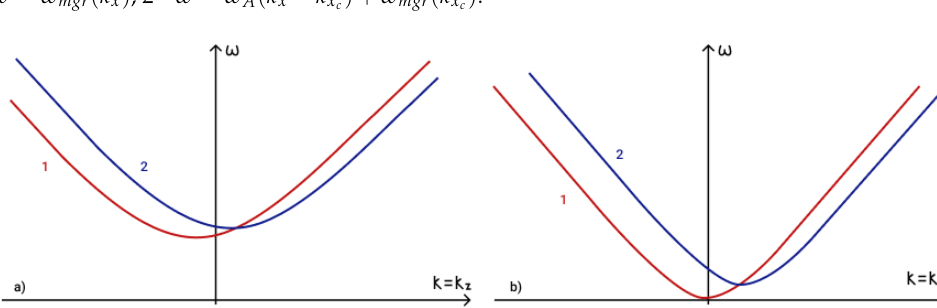
Figure 9. Phase matching condition for two magnetogravity waves and one Alfvén wave: 1—